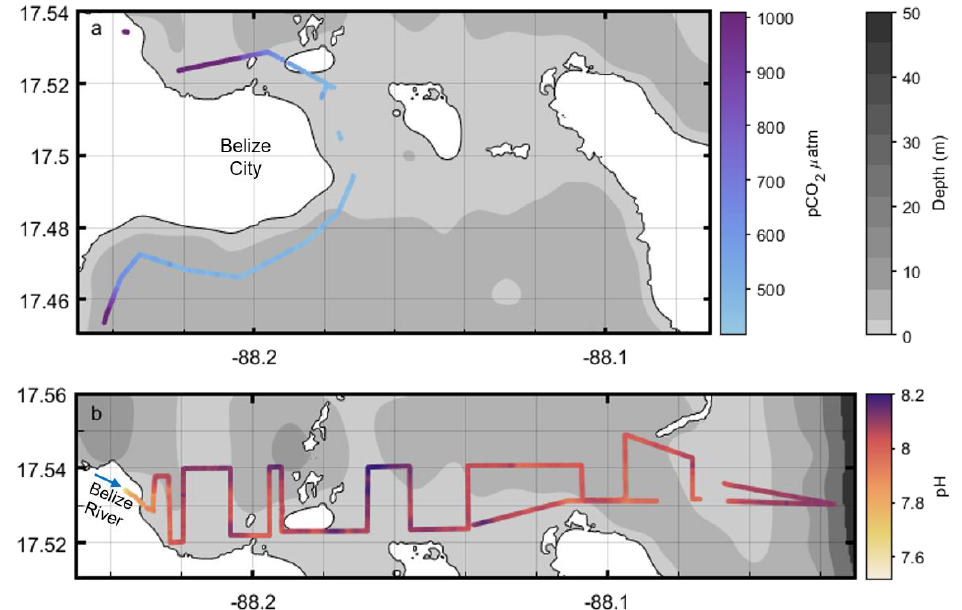
Figure 6. Carbonate chemistry parameters relevant to ocean acidification collected by the CW4 over two field seasons. ( a ) pCO 2 measurements in 2018 around Belize City showing sensor saturated (>1000 μ atm) in the river mouth, ( b ) pH measurements in Transect 1 in October 2019. Both panels show factory calibrated data. Data shown only for vehicle speeds between 4.5 and 5.5 kts.